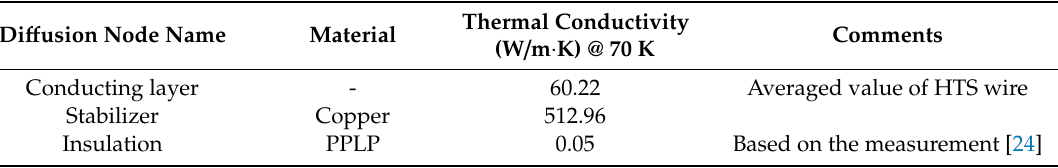
Table 8. Thermal properties of expanded 1-D network